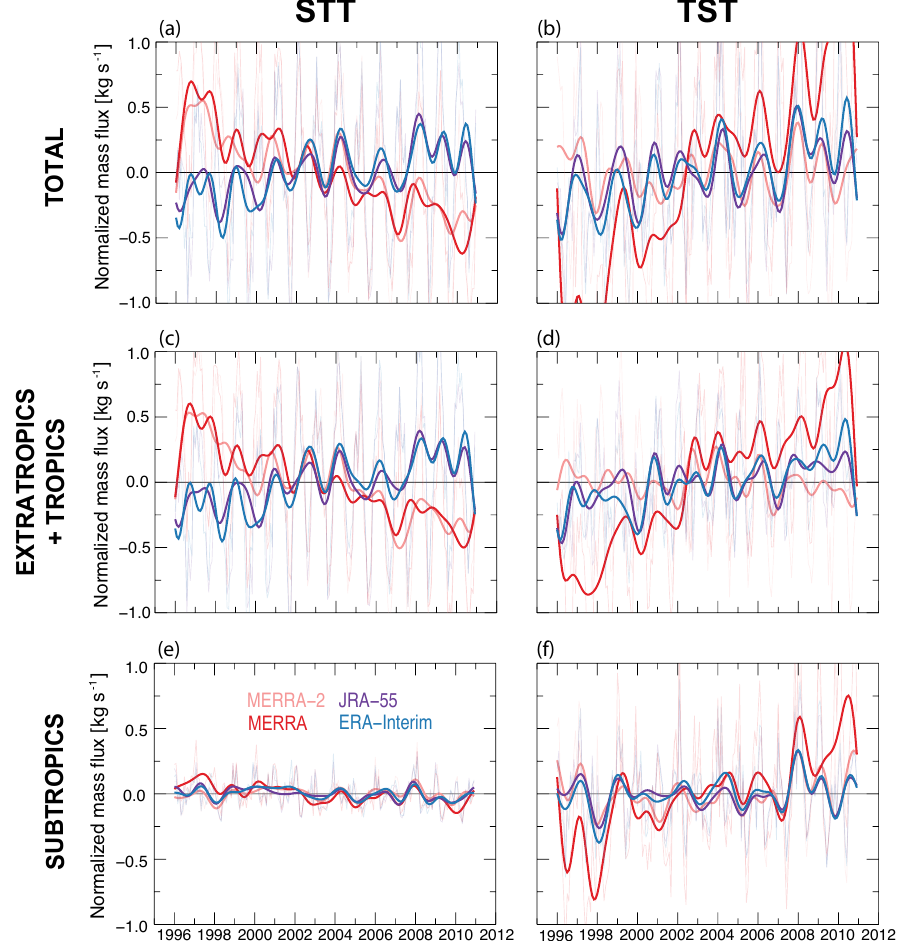
Figure 13. For each reanalysis, time series of globally integrated (top) total, (bottom) subtropical, and (middle) combined extratropical and tropical STT (left) and TST (right) mass fluxes that are with respect to the 15-year study period mean (1996–2010) are shown. The thin lines represent the monthly mean mass fluxes, while the bold lines are the result of applying a high-pass filter to a Fourier transform of each time series (power at timescales less than or equal to 12 months is removed). STE from JRA-55 is shown by the purple lines, ERA-Interim by the blue lines, MERRA-2 by the light red lines, and MERRA by the dark red